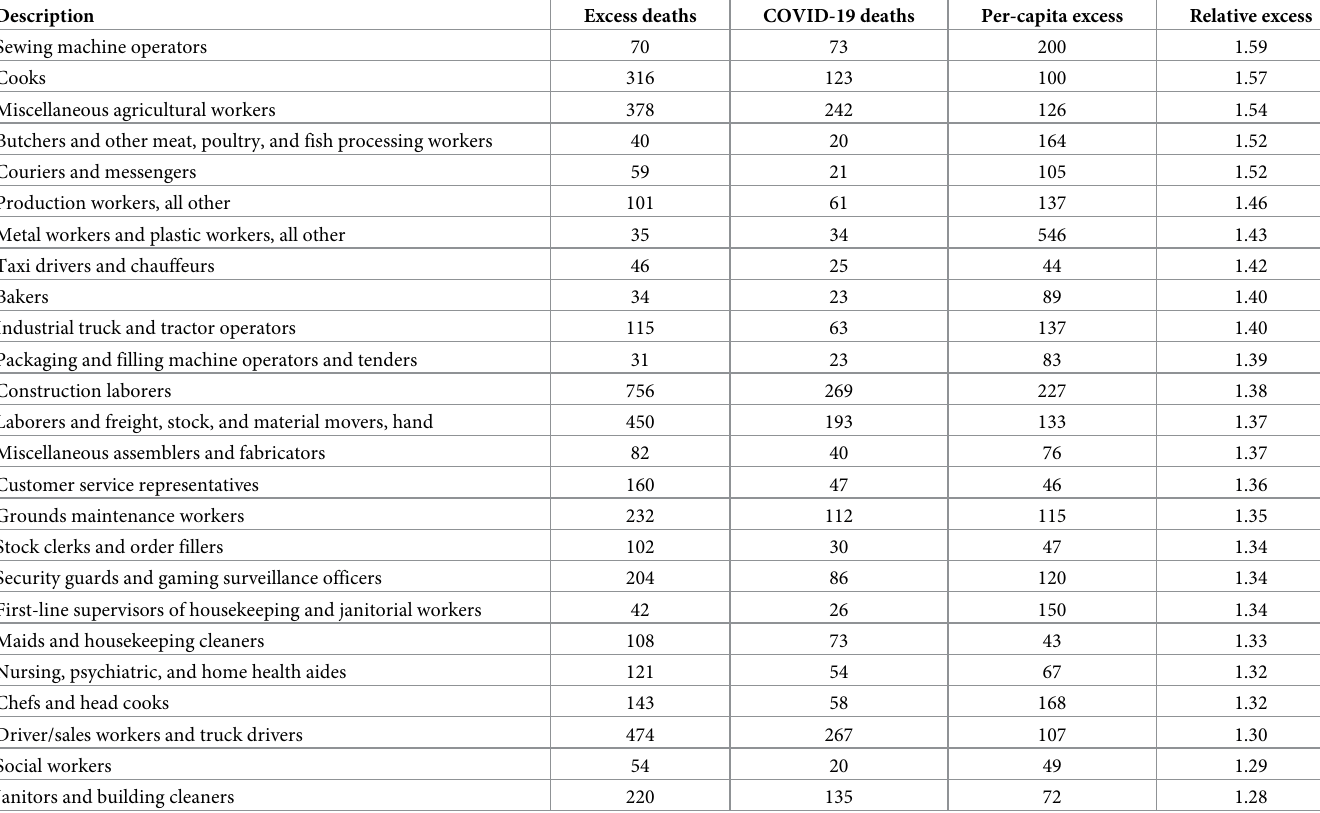
Table 4. Excess mortality among Californians 18–65 years of age, by occupation: March through November